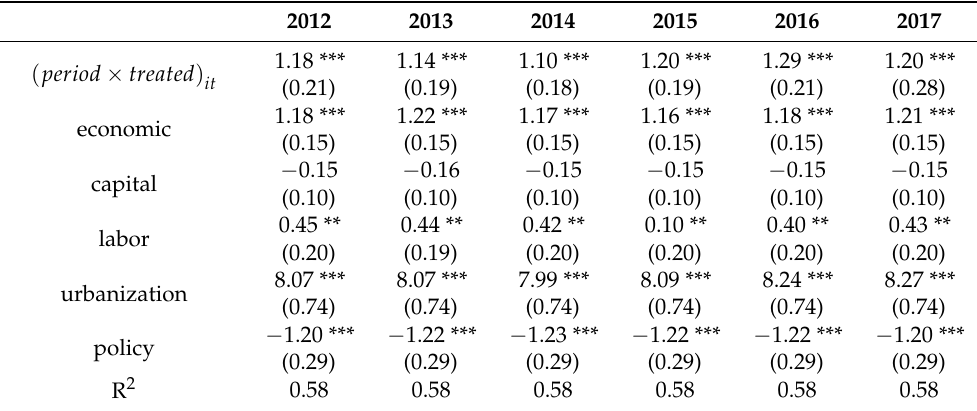
Table 4. The regression results of changing the implementation date of HSR.